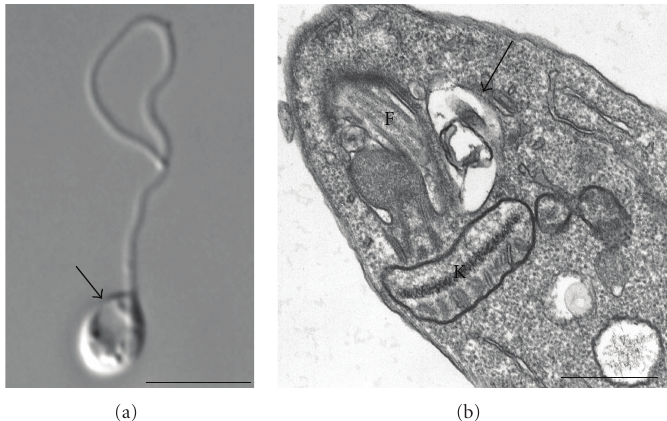
Figure 9: (a) Diferential interference contrast (DIC) microscopy and (b) transmission electron microscopy showing the presence of a prominent contractile vacuole (arrows) near the flagellar pocket after treatment of L. amazonensis promastigotes with quinuclidine inhibitors. In the left panel it is possible to observe a rounded and swollen parasite that probably indicates osmotic changes due alterations in the plasma membrane’s permeability. F, flagellum; K, kinetoplast. Bars, 5 μ m and 0 . 5 μ m,